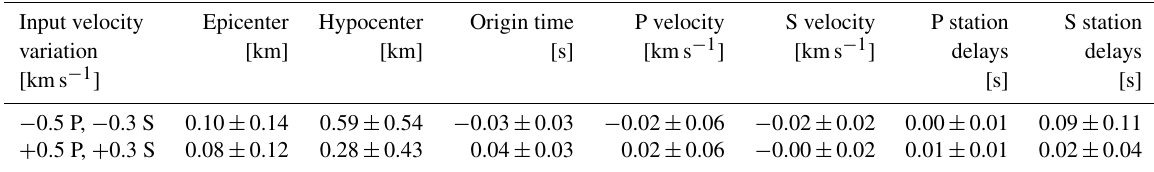
Figure 5. Selected P and S velocity model (blue) chosen after examining the results of the stability tests, relocations, and final residual values. Also shown are the median velocities (black line) and velocity percentiles (grey area) of the final P and S models as calculated in each layer. Corresponding values are given in Tables S2 and S3. Table 1. The results of the high-/low-velocity test for the MPS velocity model, given as the average and standard deviation of differences between the values obtained after the inversions with the varied models and the final parameter values. The velocity values are calculated only for the well-sampled layers between 0 and 38km. The statistics for the epicenter and hypocenter values were calculated from the lengths of vector